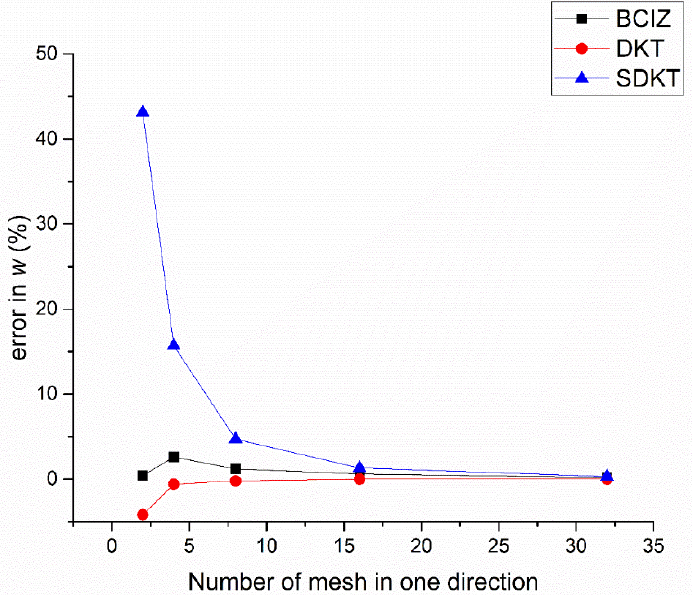
Figure 7. Error of the central deflection for a clamped square plate under uniform load.